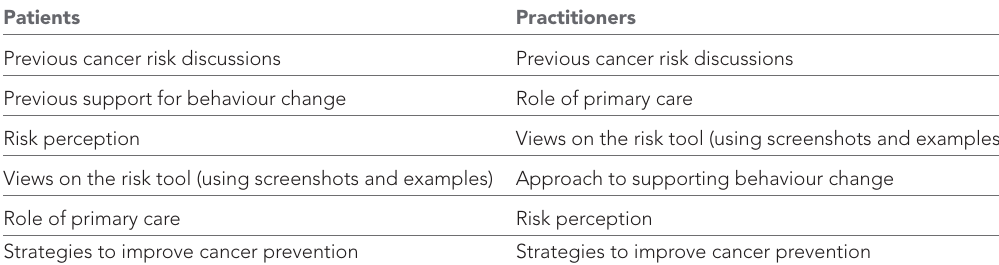
Table 2 Topic guide areas for patients and